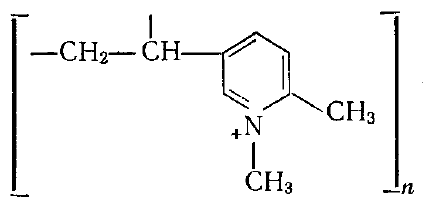
Figure 2. Structure of the active link of the VP-1AP